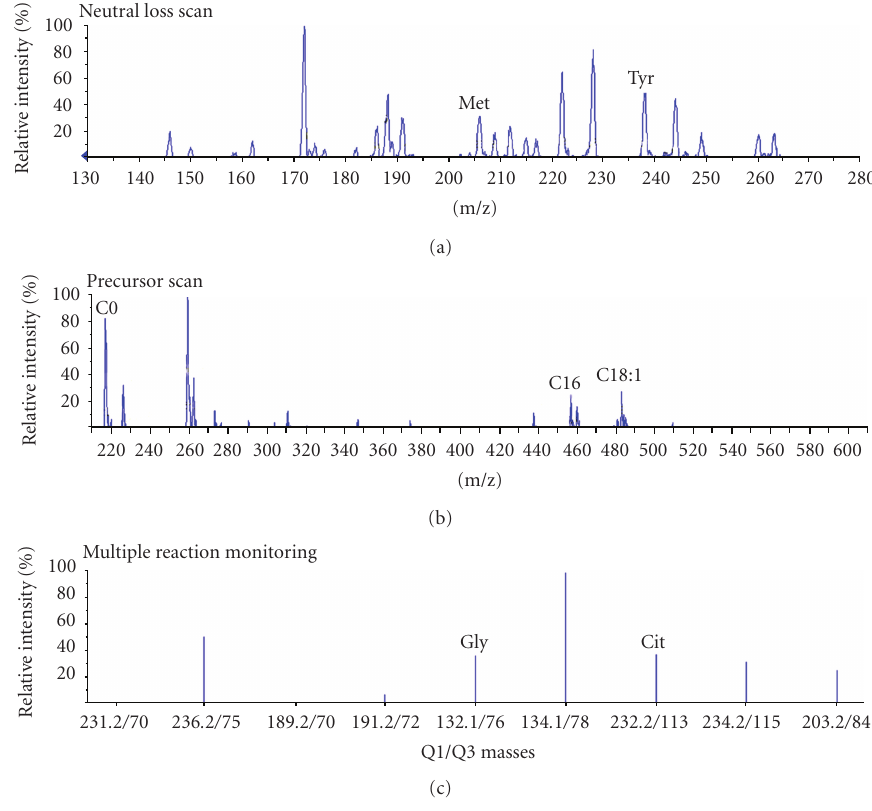
Figure 2: Chemical diagnosis of citrin deficiency by MS-MS analysis of amino and acyl carnitines in dried blood stain from a 16-month- old male toddler (C0013) with syndromic GDD. Figures 2(a), 2(b), and 2(c) are profiles of neutral loss scan, precursor scan, and multiple reaction monitoring, respectively. The amino and acyl carnitines with increased levels were labeled as abbreviations, with Met, Tyr, Gly, Cit, C0, C16, and C18 :1 representing methionine, tyrosine, glycine, citrulline, free carnitine, palmitate, and hydroxypalmitate,